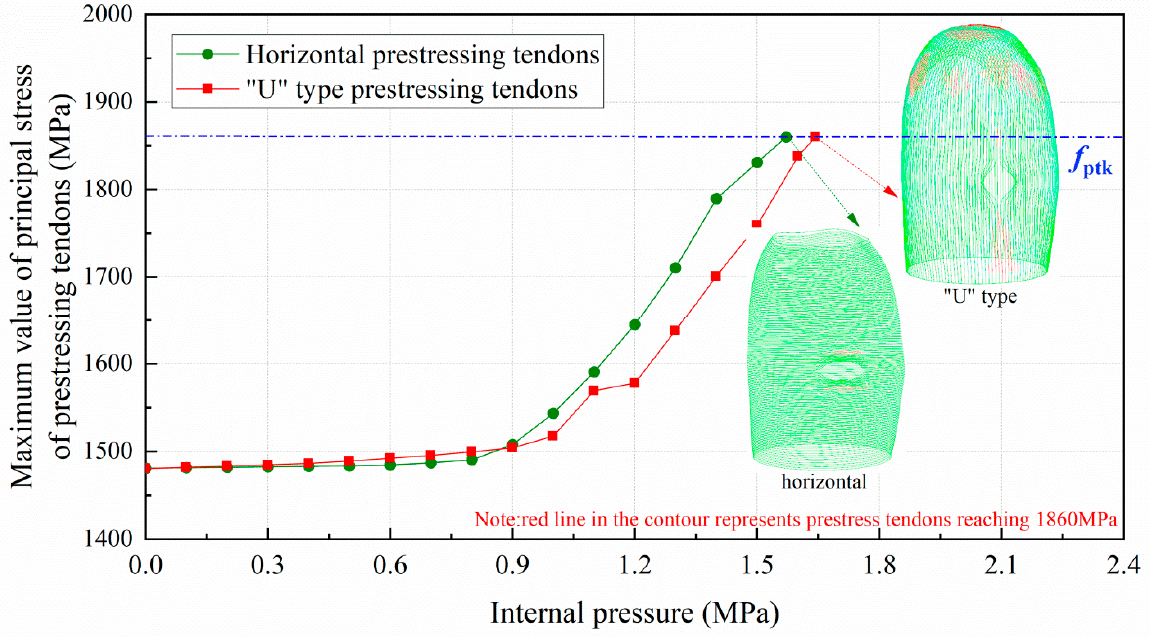
Figure 10. Maximum value of principal stress of prestressing tendons.